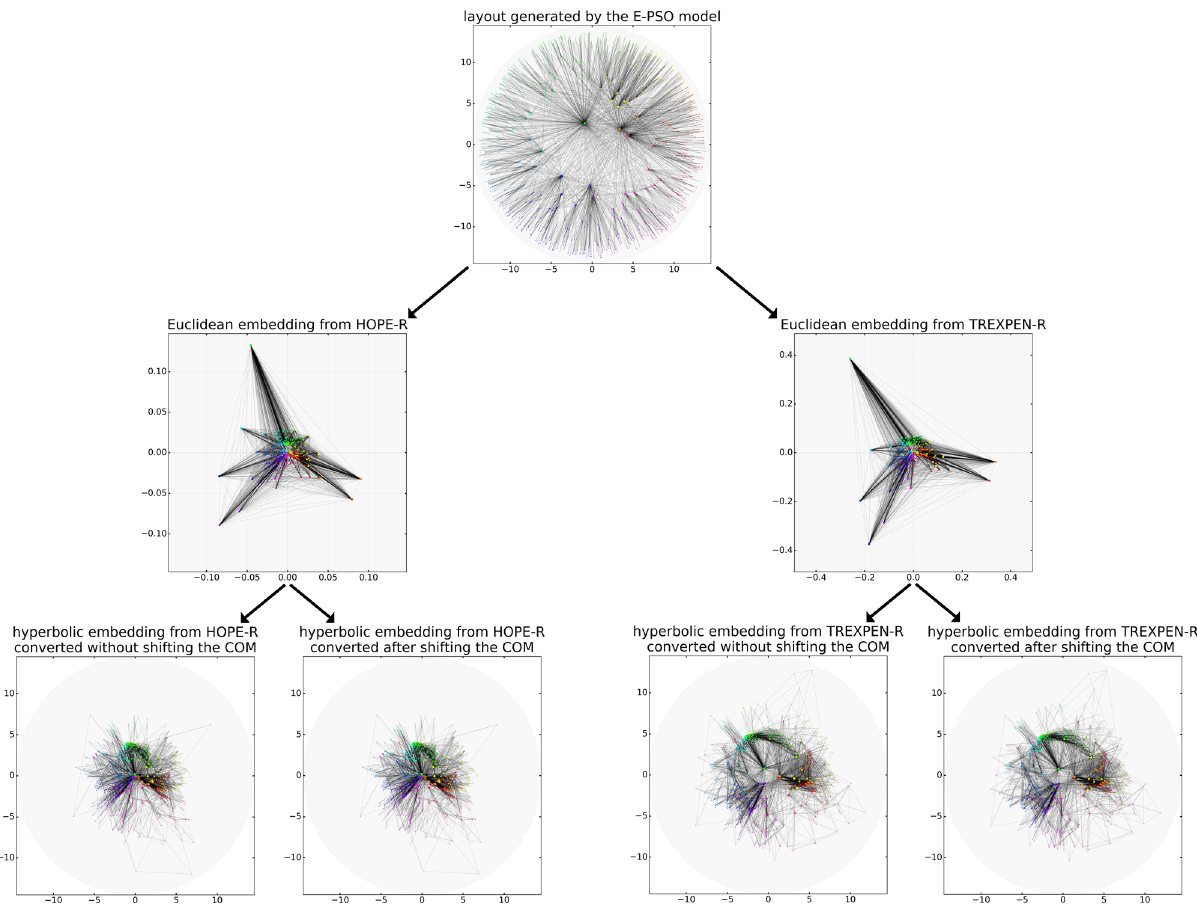
Fig. 2 Demonstration of our Euclidean-hyperbolic conversion method MIC. Here we use embeddings of an undirected network that was created by a generalised version of the popularity-similarity optimisation model. The node degrees are indicated by the node sizes: nodes with more connections are depicted by larger markers. The nodes are coloured in each layout according to the angular coordinates originally assigned in the hyperbolic plane of curvature K = − ζ 2 = − 1 by the E-PSO model. The depicted HOPE-R embeddings were created using α = 5.97 ⋅ 10 − 3 , while the TREXPEN-R layouts were obtained at q = 3.89. We used C = 2 and ζ = 1 for all the hyperbolic embeddings. We also show the result of carrying out the optional step of shifting the centre of mass (COM) of the Euclidean node arrangement before converting it to a hyperbolic